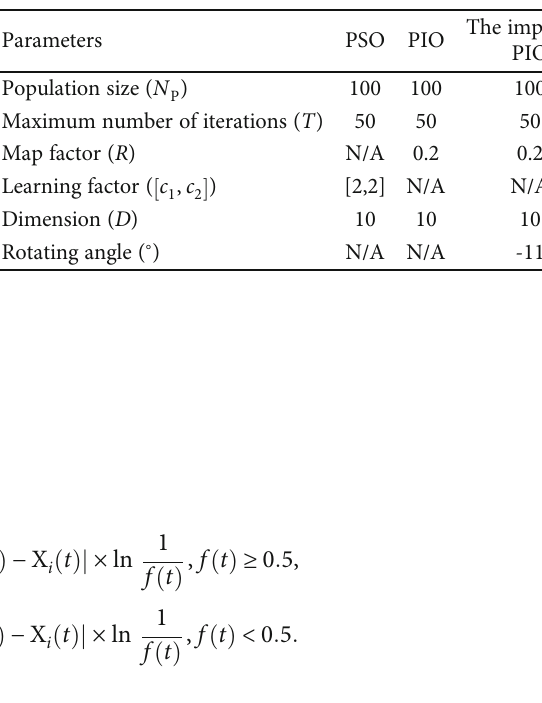
Table 1: Test function optimization results. Table 2: Parameters of global optimization